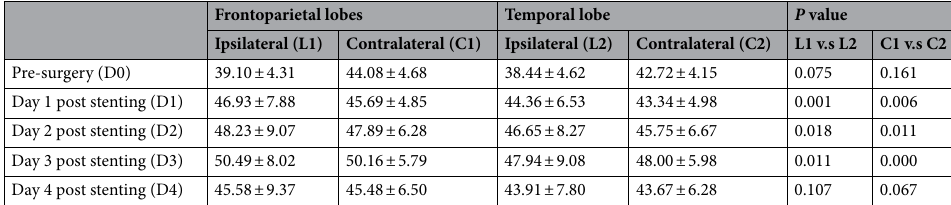
Table 3. The cerebral blood flows (mL/100 g/min) in frontoparietal and temporal lobes of patients receiving CAS.